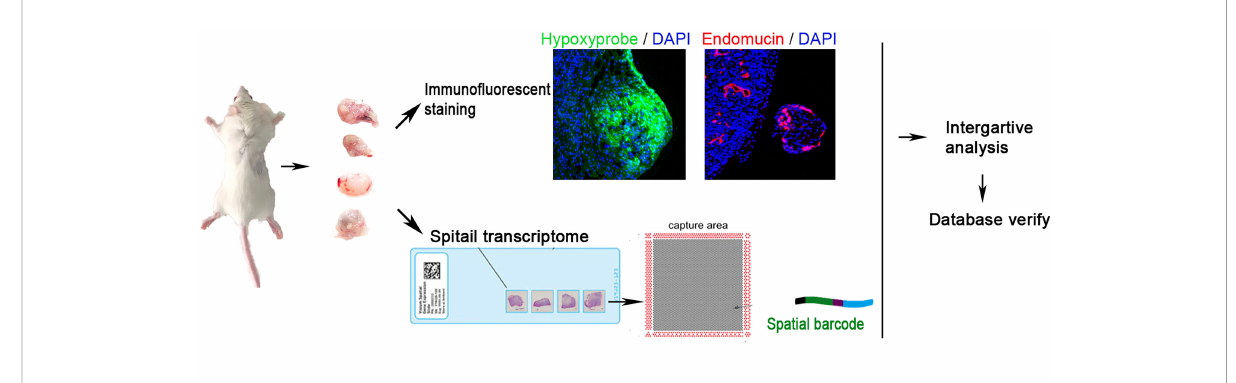
FIGURE 1 Work fl ow of claudin-low breast cancer sample processing for ST. Four tumors were collected in this study. They were sectioned and placed on four capture areas of the same slide,